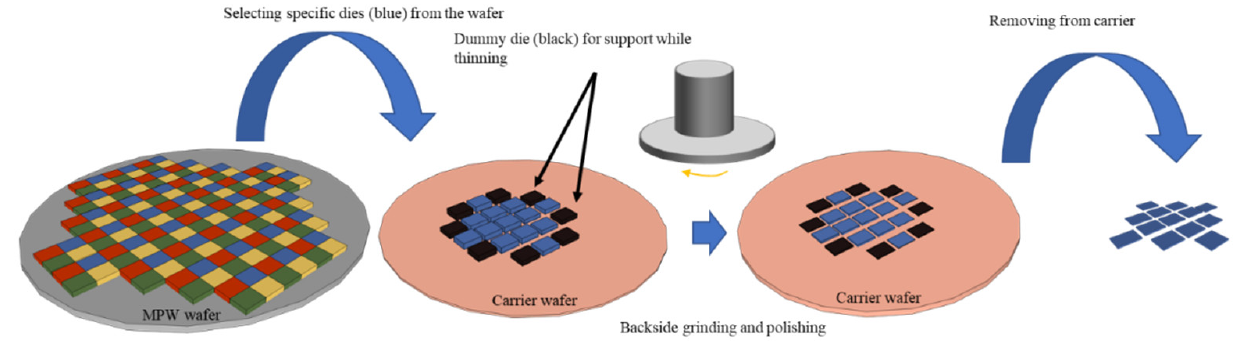
Figure 2. Die-level thinning of the multi-project-wafers.